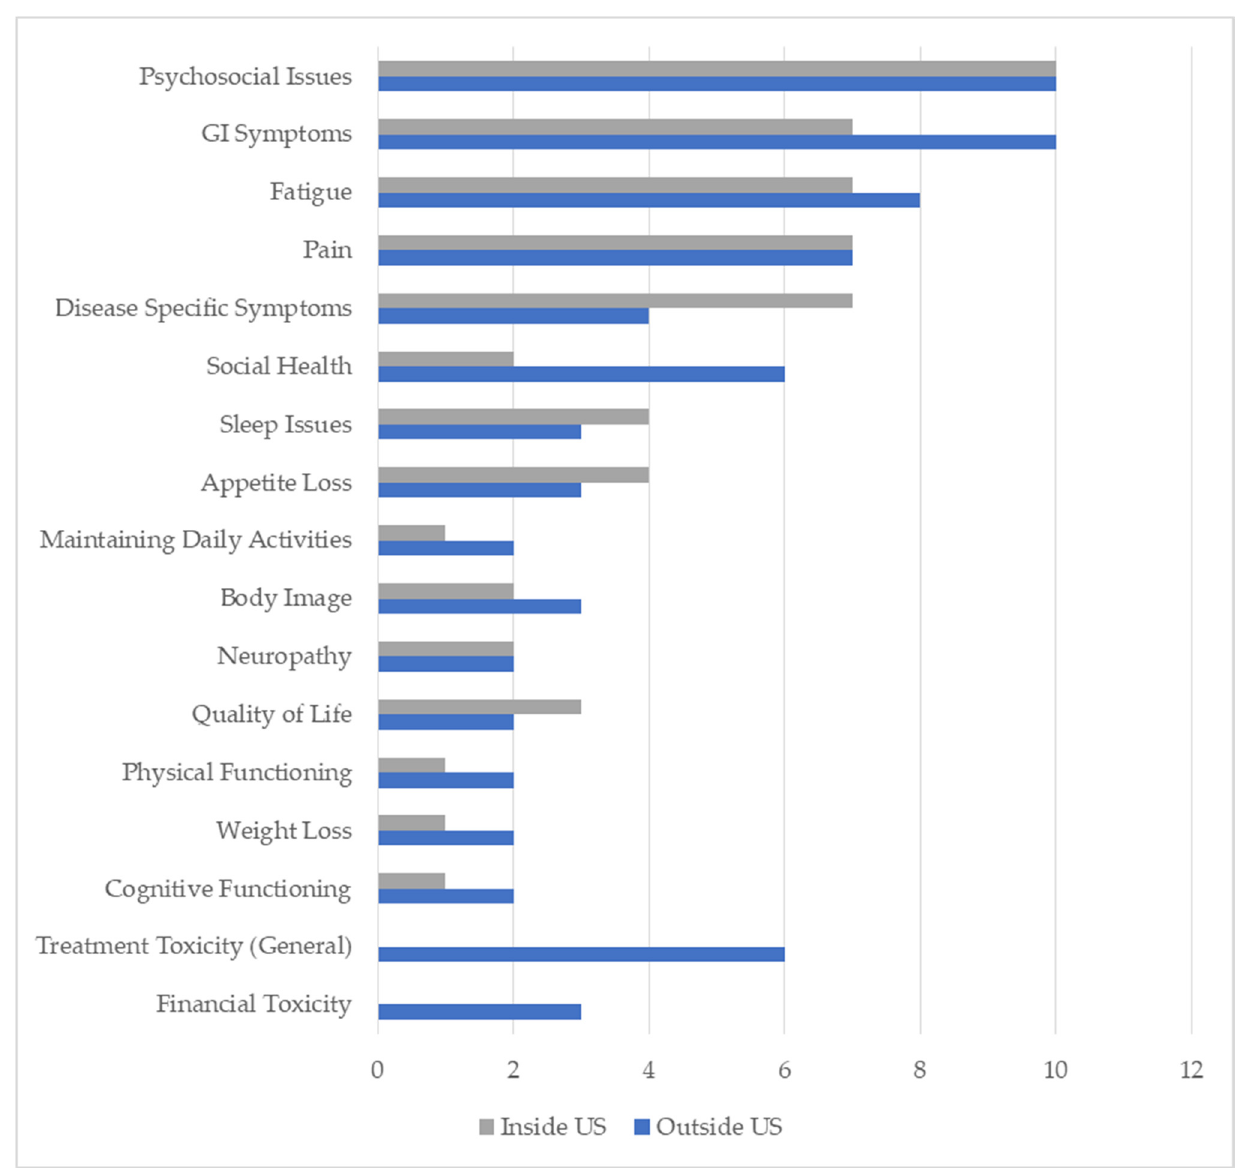
Figure 2. Number of articles per identified domain by location (in/outside US).